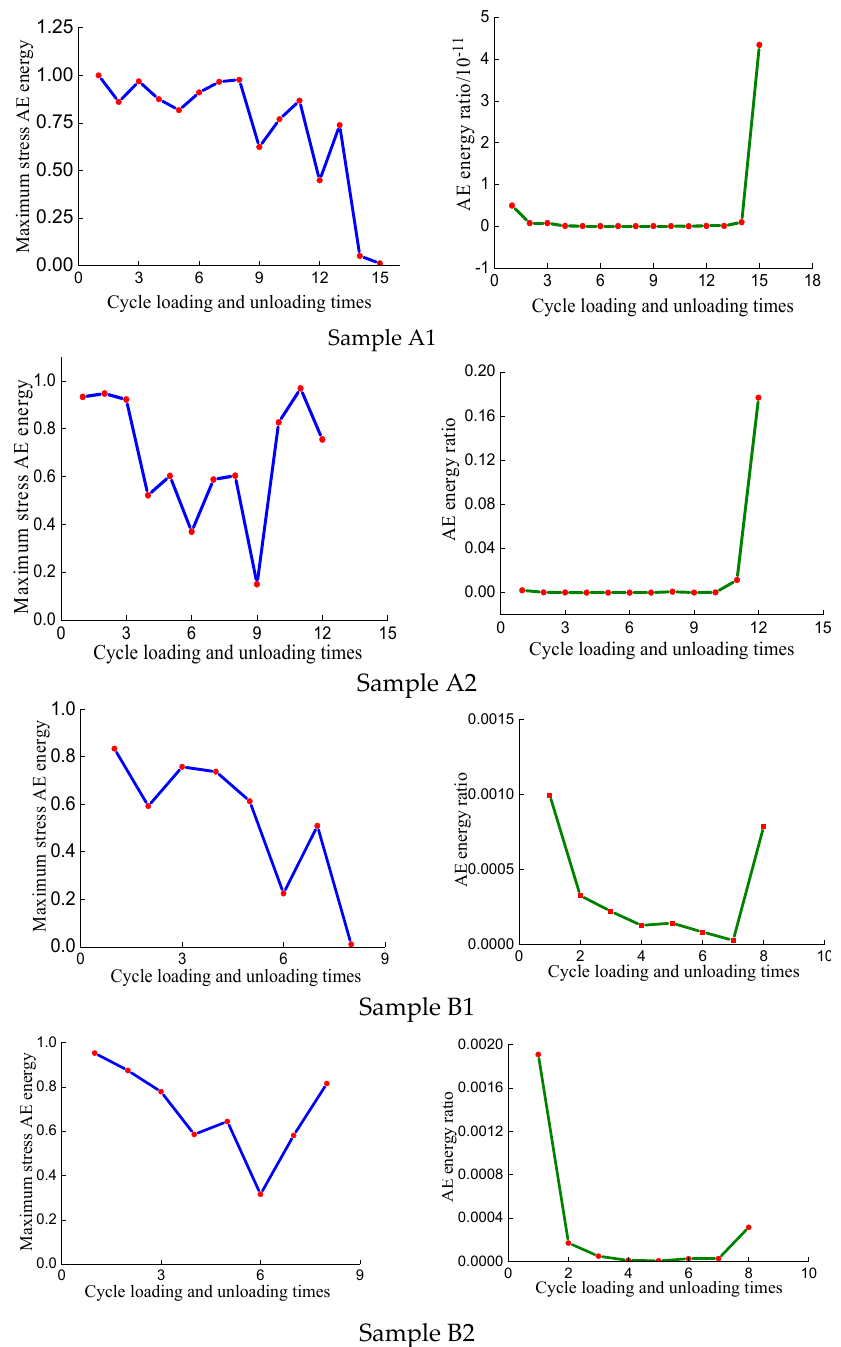
Figure 15. The trend of the ratio of absolute energy of rock acoustic emission with the number of cyclic loading and unloading steps.